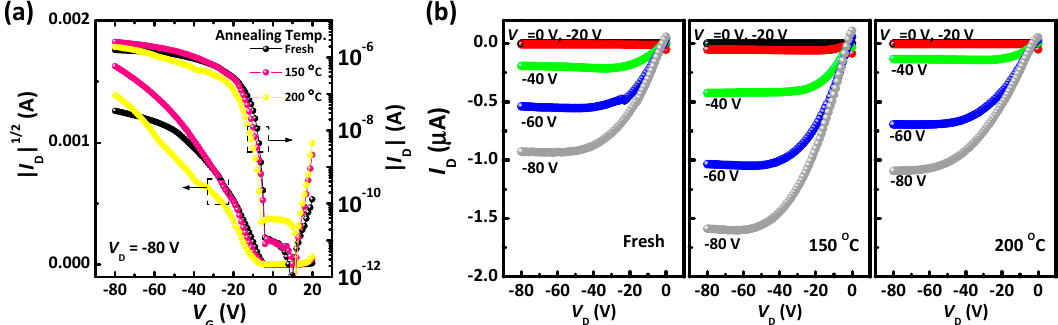
Figure 2. ( a ) Transfer characteristics and ( b ) output characteristics of the OFETs with pristine and annealed PQCTQx films. Table 1. Performance measures of various OFETs with different PQCTQx films.